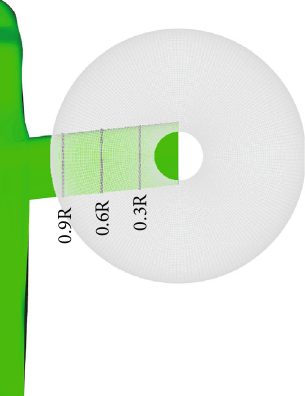
Figure 25: Spanwise stations on the